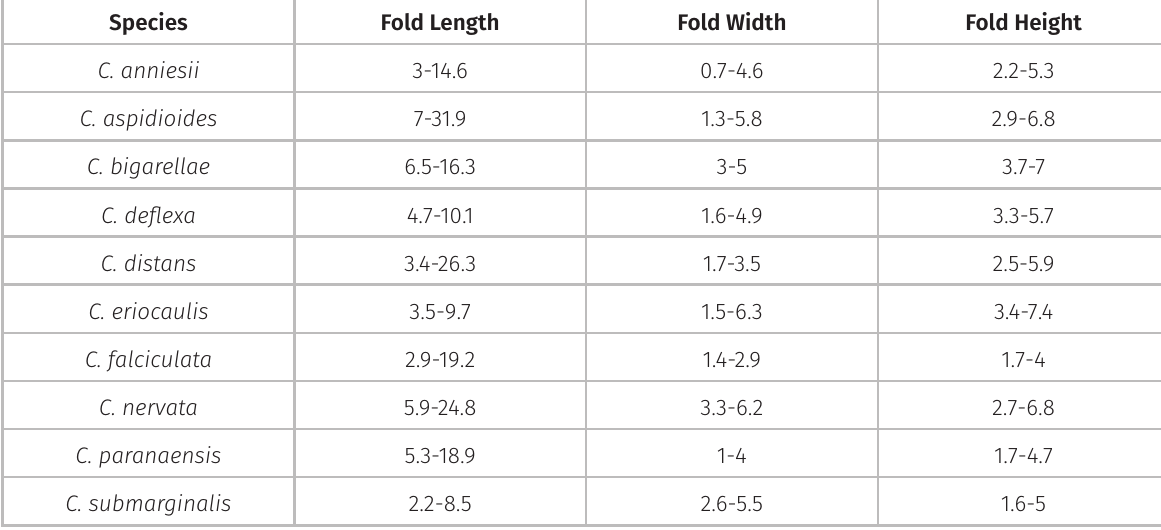
Table II. Folds measurements of the rugated spores of Ctenitis from Southern Cone of South America. Dimensions in